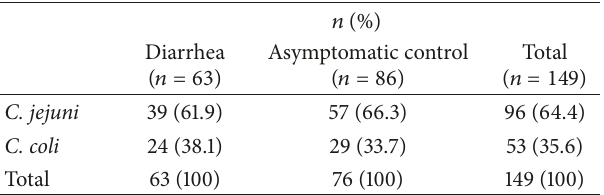
Table 2: Samples